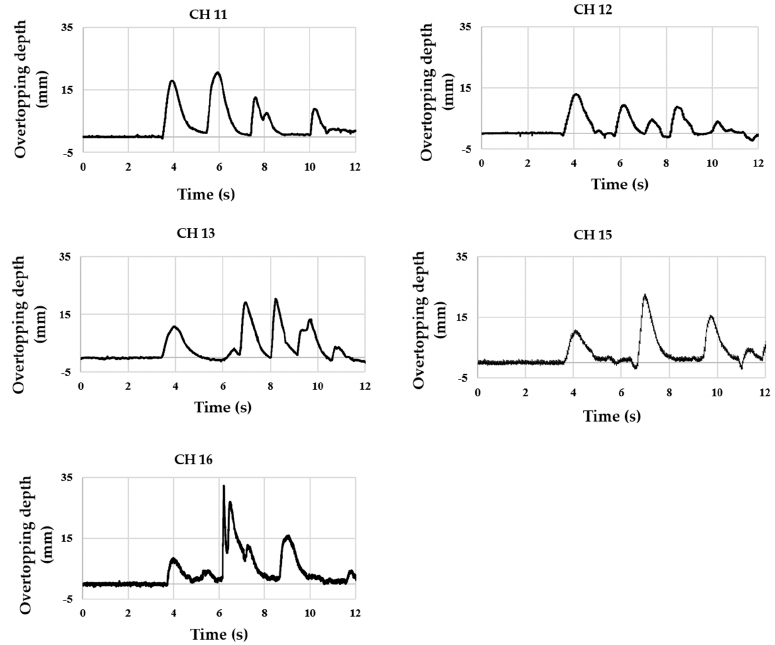
Figure 12. Overtopping depth (mm) versus time (s) over the five dam crest sections (see Figure 6 for the locations of the sensors) (Test no. 185_2.25s_4.5_2H_200).